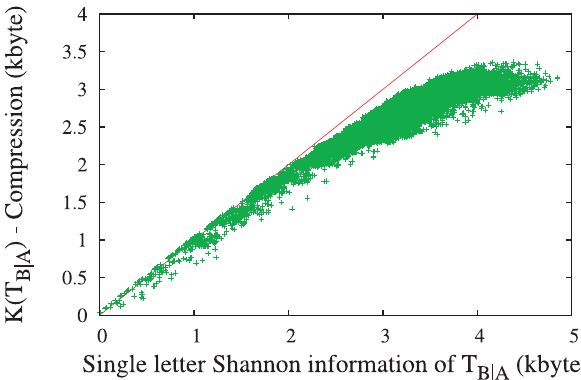
Figure 4. Scatter plot comparing K ( T B D A ) estimated using compression, to the single letter Shannon information h 1 ( T B D A ) . The diagonal, X ~ Y , is a guide for the eye. Points falling below the diagonal indicate cases where T B D A is not independent and identically distributed, and some letters show strong correlations. The fact that K ( T B D A ) is slightly larger than h 1 ( T B D A ) for low entropy translation strings corresponds to the initiation cost for lpaq1 compression, which is & 30 byte independently of the sequence. The plot shows & 30,000 pairs taken from all over the animal kingdom.